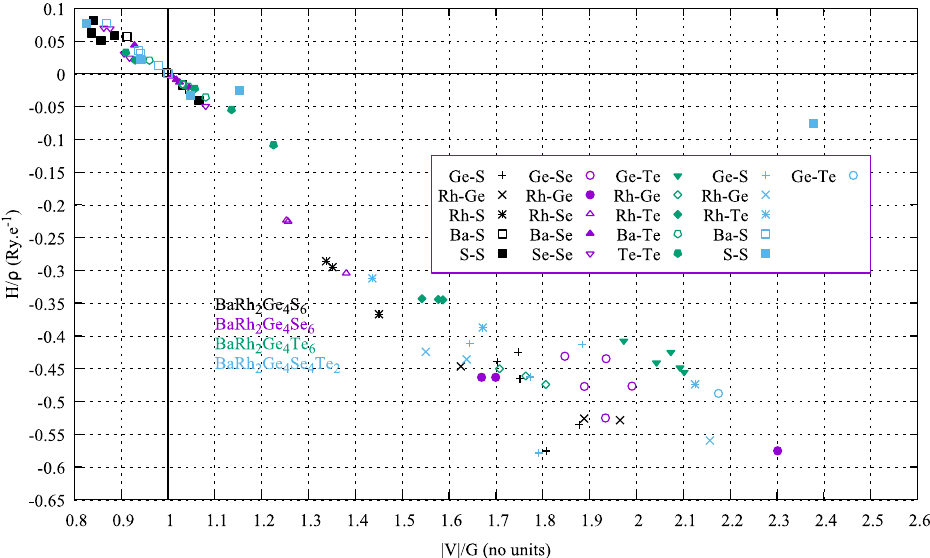
Figure 10. Bond degree vs. | V | / G for the BaRh 2 Ge 4 X 6 (X = S, Se, Te) and BaRh 2 Ge 4 S 4 Te 2